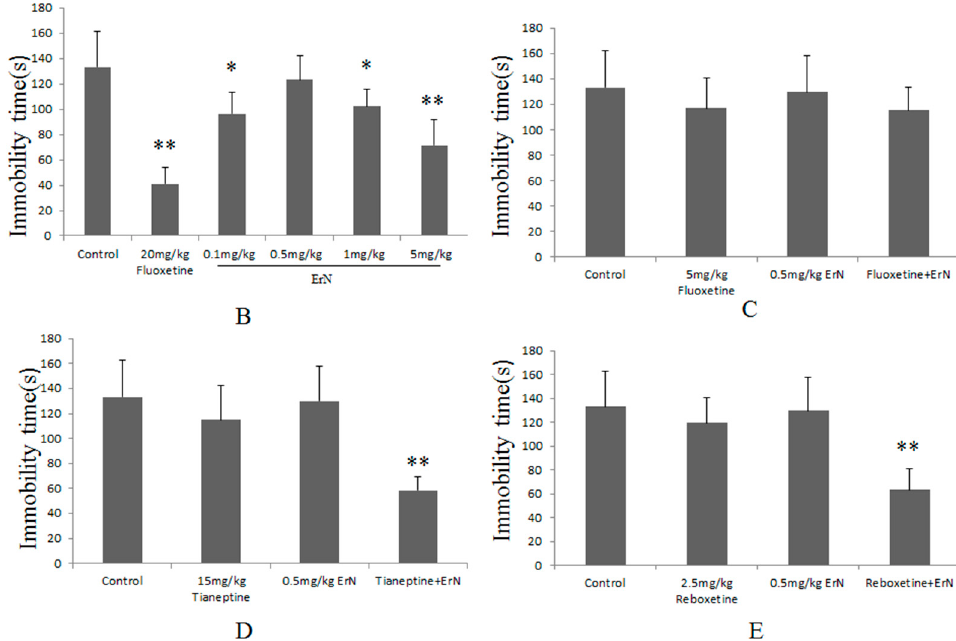
Figure 2. ( A ) shows the antidepressant-like effect of different doses of Er and its derivatives in the FST; ( B ) shows the antidepressant-like effect of different doses of ErN in the FST; ( C ) shows the antidepressant-like effect of the co-administration of sub-effective doses of ErN (0.5 mg/kg, i.p.) with fluoxetine (5 mg/kg, i.p.) in the FST; ( D ) shows the antidepressant-like effect of the co-administration of sub-effective doses of ErN (0.5 mg/kg, i.p.) with tianeptine (15 mg/kg, i.p.) in the FST; ( E ) shows the antidepressant-like effect of the co-administration of sub-effective doses of ErN (0.5 mg/kg, i.p.) with reboxetine (2.5 mg/kg, i.p.) in the FST. The values represent the mean ± SD ( n = 10 in each group), compared with the control group, * p < 0.05, ** p < 0.01. One way ANOVA, post-hoc Tukey